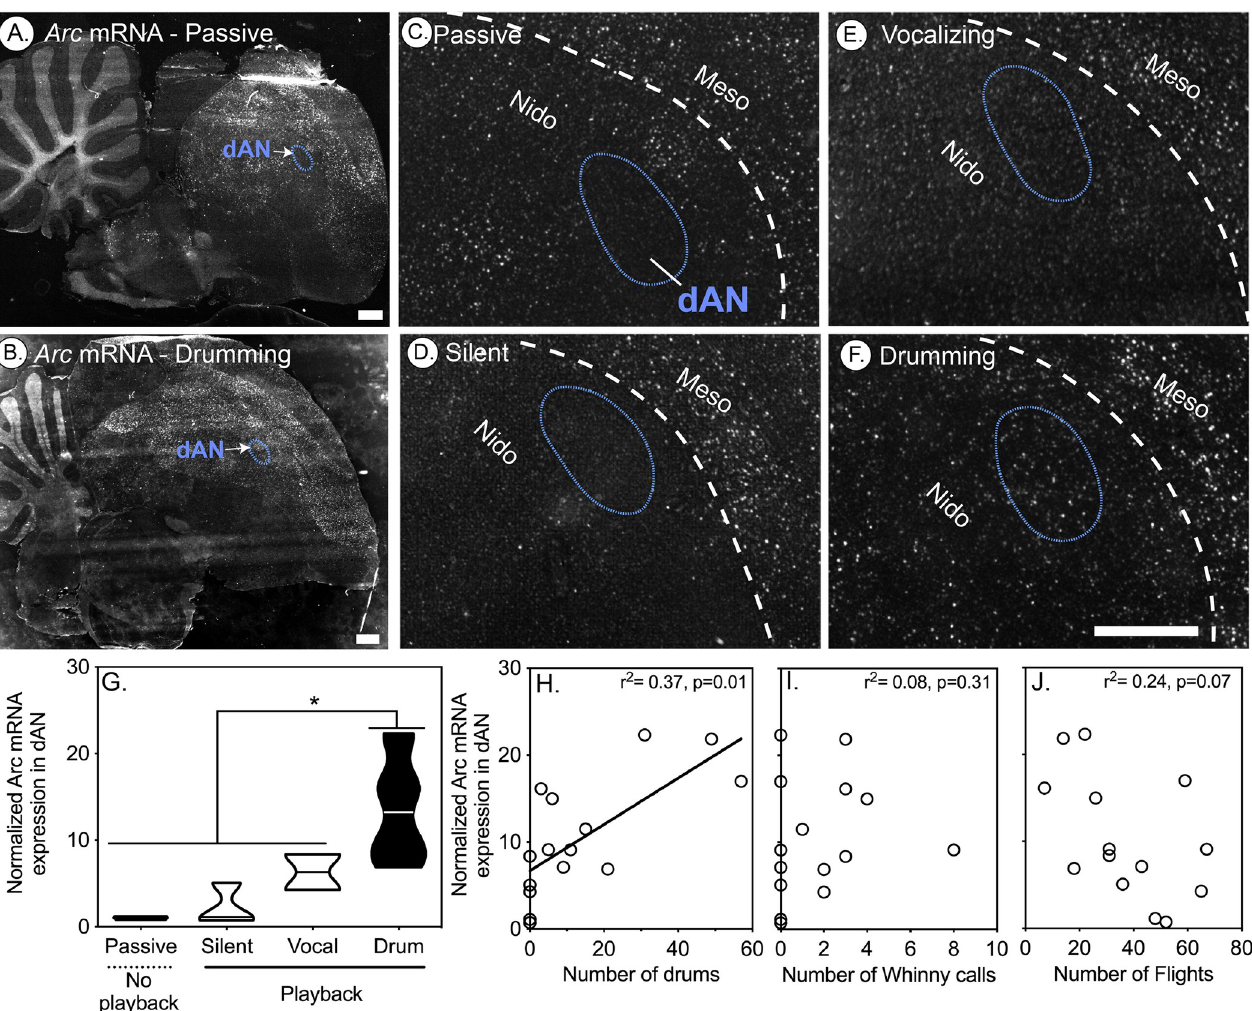
Fig 5. Activity induced Arc expression in the dorsal anterior nidopallium (dAN) of downy woodpeckers positively correlates with drumming behavior. (A-B) Representative low-magnification in situ hybridization microscope images of Arc expression (white), with fast red as a counterstain (grey) in downy woodpeckers that were either passively caught (A) or (B) after drumming during a simulated territorial encounter (STI). (C-F) Representative high- magnification examples of Arc mRNA image in (C) passively caught birds ( n = 3) or birds that listened to STI playback (see Materials and methods) but either (D) did not produce vocalizations or drums (silent, n = 3), (E) produced only vocalizations and no drums ( n = 2), or (F) produced drums ( n = 10). Dash blue outline represents the PV -rich dAN area on each section determined from PV mRNA on an adjacent section. (G) Violin plots (horizontal line denotes median) illustrating differences in Arc gene expression in the PV -rich dAN in male downy woodpeckers caught after producing different behaviors. Arc mRNA expression significantly differed in the dAN ( F = 21.14, p < 0.001), with drumming birds showing higher Arc expression than all other groups (all relevant 3 , 14 comparisons: p < 0.01). (H) Arc mRNA expression in the dAN nucleus was positively correlated with the number of drums ( p = 0.01). (I) No correlation was detected with the total number of aggressive vocalizations. Yet, (J) there was a marginally significant negative correlation with woodpeckers that flew less having greater Arc mRNA expression in dAN. Significant correlations denoted by solid lines ( p < 0.05). Dashed white lines in images indicate boundaries between nidopallium and mesopallium, whereas blue dashed lines indicate specialized PV regions identified in downy woodpeckers. Data for G-J can be found in S2